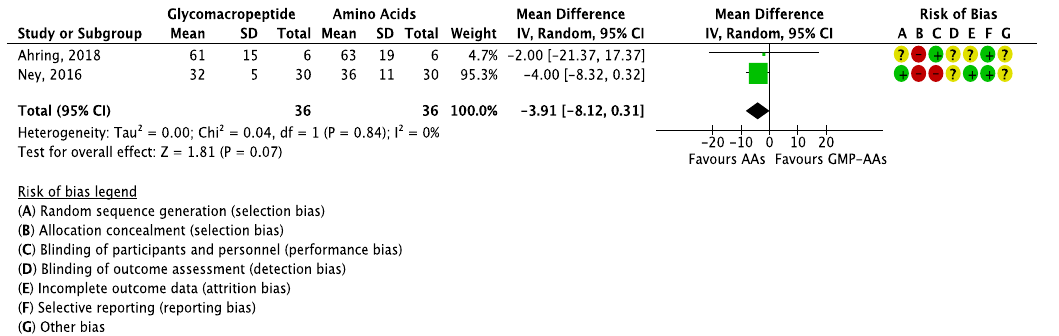
Figure 4. Forest plot of studies with data on the effect of glycomacropeptide interventions on blood phenylalanine levels. The analysis included data from two studies with a total of 72 participants. AAs: synthetic protein derived from L-amino acids; CI: confidence interval; df: degrees of freedom; GMP-AAs: glycomacropeptide supplemented with amino acids; IV: intravitreal; SD: standard deviation. The overall treatment effect on blood Tyr levels was not statistically significant (MD = −3.91 μmol/L (−8.12, 0.31); I 2 = 0%; P = 0.07; two studies; N = 72 participants; Figure 5) and patients treated with AAs tended to have higher levels of Tyr.